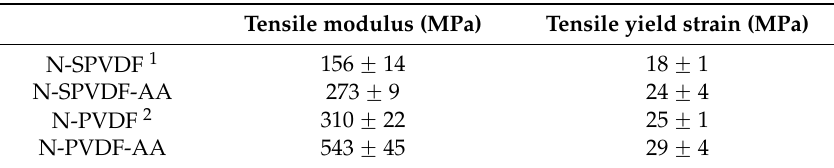
Table 2. Mechanical properties of PVDF and functionalized membranes.